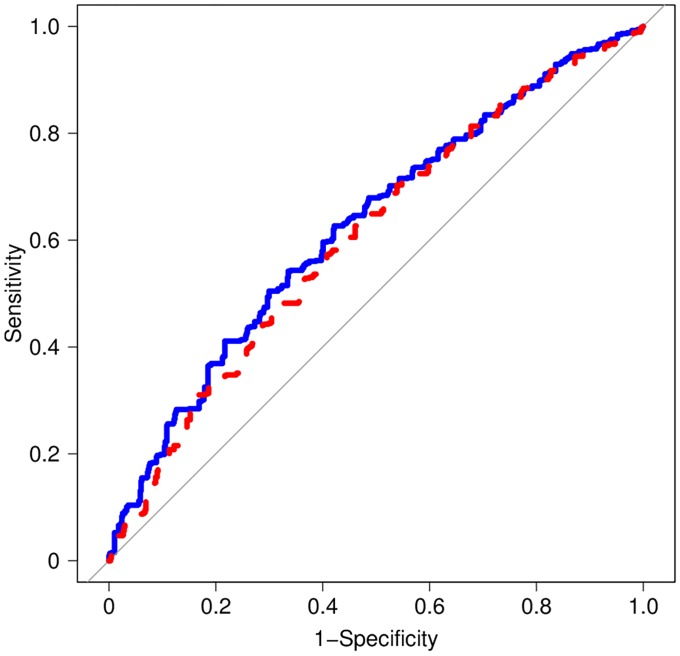
ROC curves for models A and B incorporating different variables according to the LOOCV method.Model A (blue line) incorporates classical risk factors and five GWAS-identified SNPs, whereas model B (red dashed line) includes only the five GWAS-identified SNPs. AUC values (95% CI) for models A and B are 0.63 (0.60–0.66) and 0.61 (0.58–0.64), respectively. The gray diagonal line corresponds to an AUC of 0.5 and no discrimination.